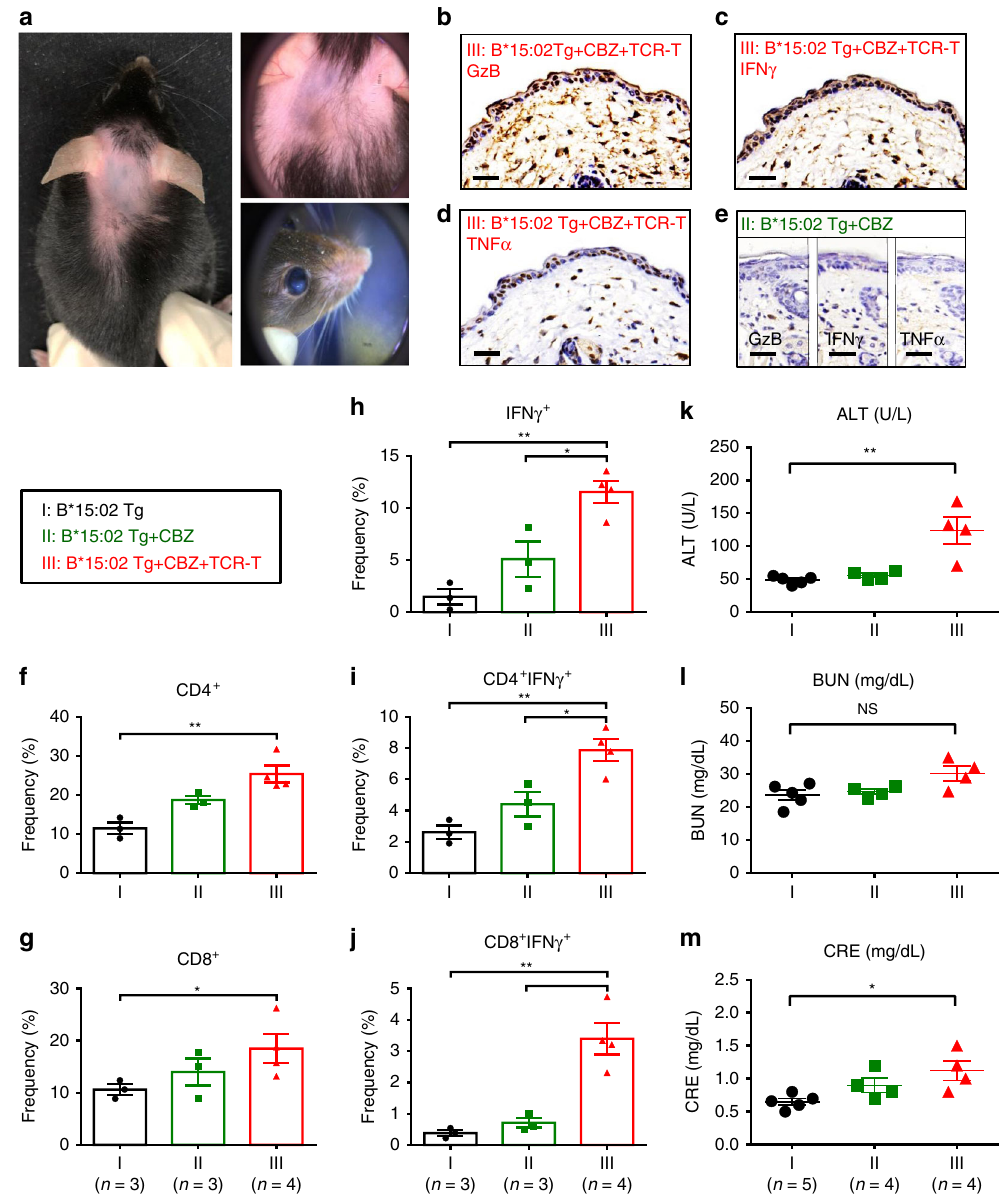
Fig. 7 Adoptive transfer of TCR-T lymphocytes to HLA-B*15:02 transgenic mice. HLA-B*15:02 transgenic mice were assigned to the group (I) the vehicle controls ( n = 5); group (II) given carbamazepine daily (328 mg/kg/day) by oral gavage ( n = 4); and group (III) given carbamazepine daily and adoptive transfer of the public TCR-T ( n = 4). Photographs, biopsies of the affected skin, and peripheral blood were obtained. a Representative photos of the affected skin and eyes of the group III mice are shown. b – e Immunohistochemistry staining of the skin biopsies of the mice. Compared with the group II, the group III mice showed augmented expression of cytotoxic protein granzyme B (GzB), and in fl ammatory cytokines, including IFN γ and TNF α . The results are representative of three independent experiments. Scale bar indicates 100 µ m. f – j The frequencies of CD4 + , CD8 + , and/or IFN + lymphocytes in the peripheral blood of the mice group I ( n = 3), group II ( n = 3), and group III ( n = 4). The results are expressed as mean ± s.e.m. with each dot representing the data of an individual mouse. Statistical analysis was performed using an unpaired, two-tailed Student ’ s t test. k – m The plasma levels of ALT (alanine aminotransferase), BUN (blood urea nitrogen), and CRE (creatinine) were determined in the mice group I ( n = 5), group II ( n = 4), and group III ( n = 4). The levels of each parameter are plotted as the mean ± s.e.m. with each dot representing the data of an individual mouse. Statistical analysis was performed using an unpaired, two-tailed Student ’ s t test. * P < 0.05; ** P <